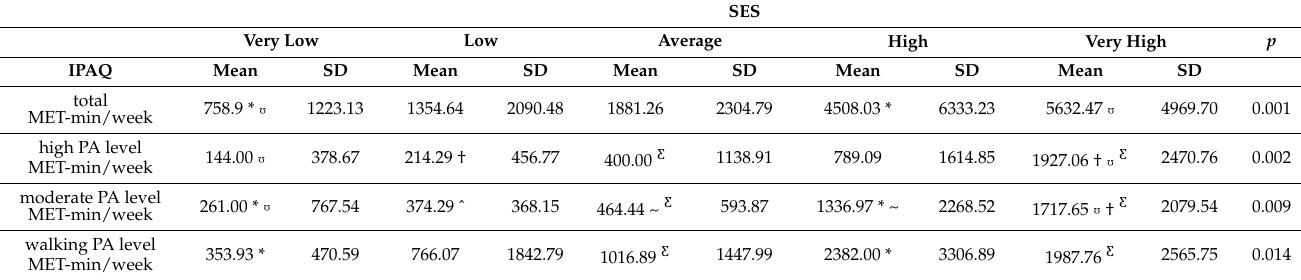
Table 3. Relationship between physical activity level (IPAQ) and self-esteem (SES).